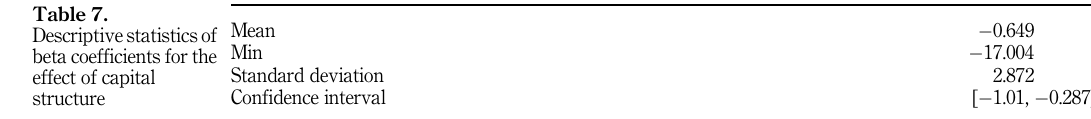
Table 6. Study results on the relationship between leverage and firm performance